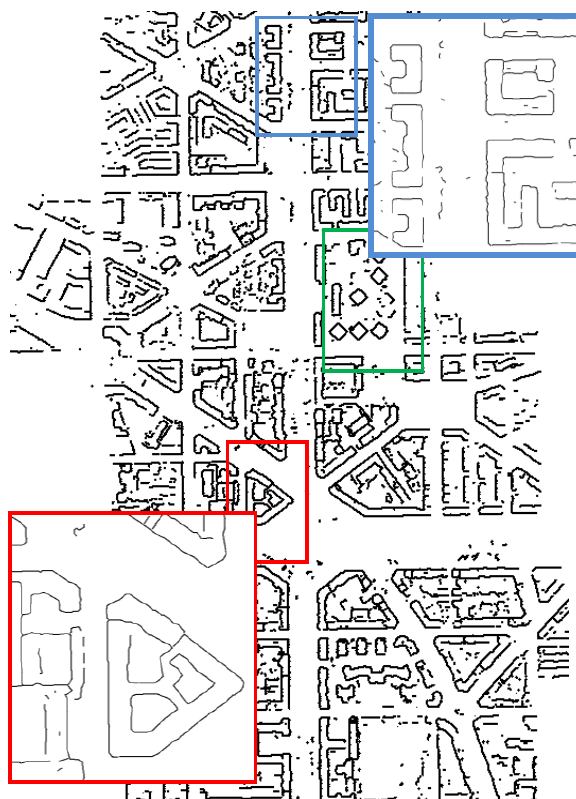
Figure 9. Building outlines extracted in the first test area.